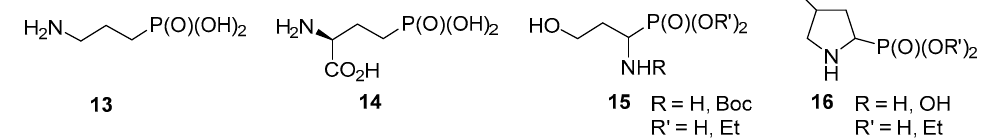
Figure 3. Examples of phosphonate analogues of amino acids.